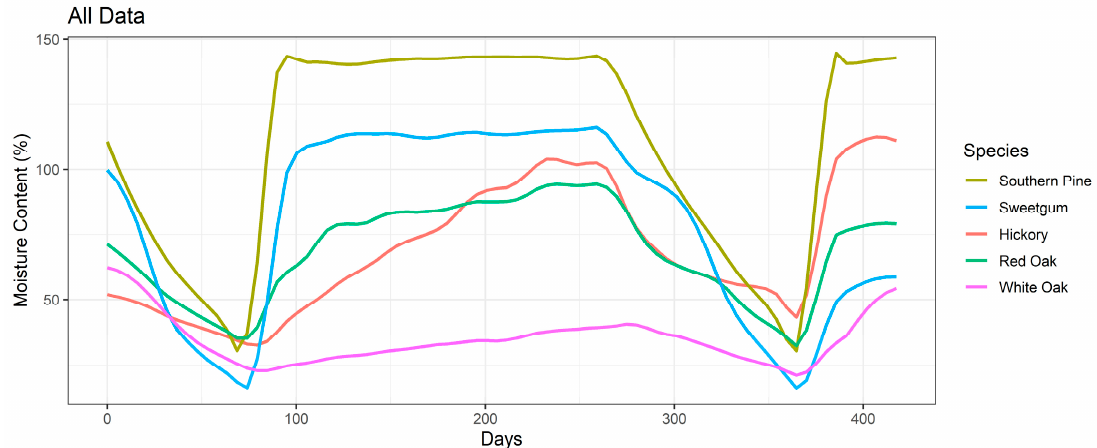
Figure 6. Predicted moisture content following successive wet-dry cycles.